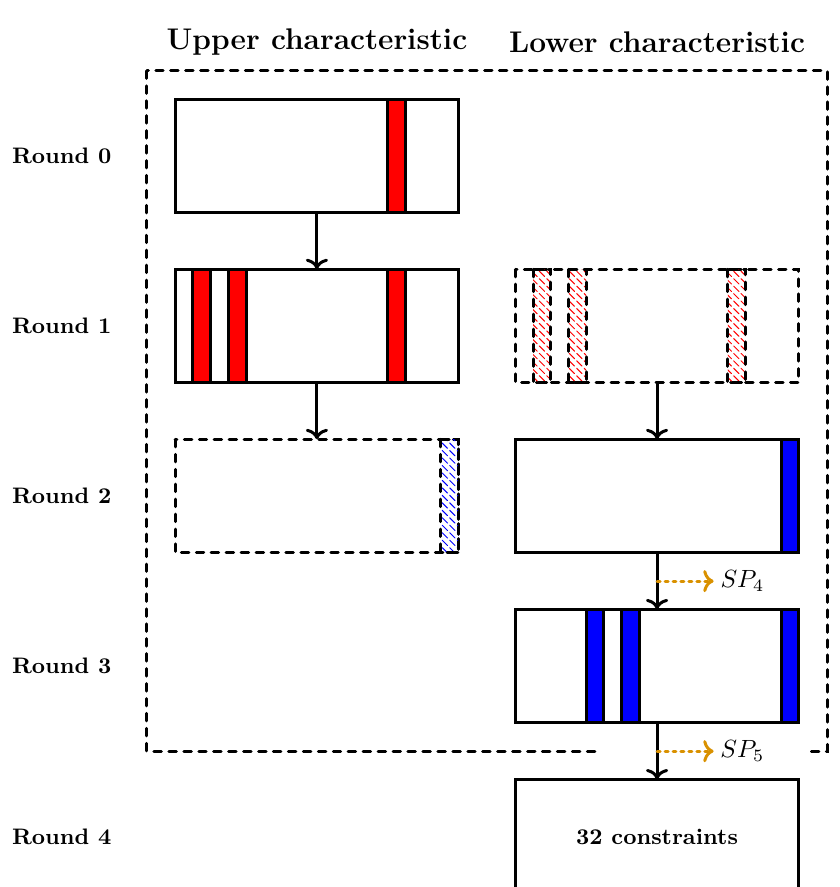
Figure 4: An illustration of the starting points for non-black-box rectangle distinguisher for 4 and 5 rounds. The red and blue bars show the rough position of the active Sboxes for the upper characteristic and lower characteristic respectively. The starting point for the 4-round distinguisher, ( SP 4 ), fixes 6 (linear) constraints for the 3 Sboxes in round 3 while the starting point for the 5-round distinguisher, ( SP 5 ), fixes 3 (linear) constraints for the 3 Sboxes in round 3 and 32 (linear) constraints in round